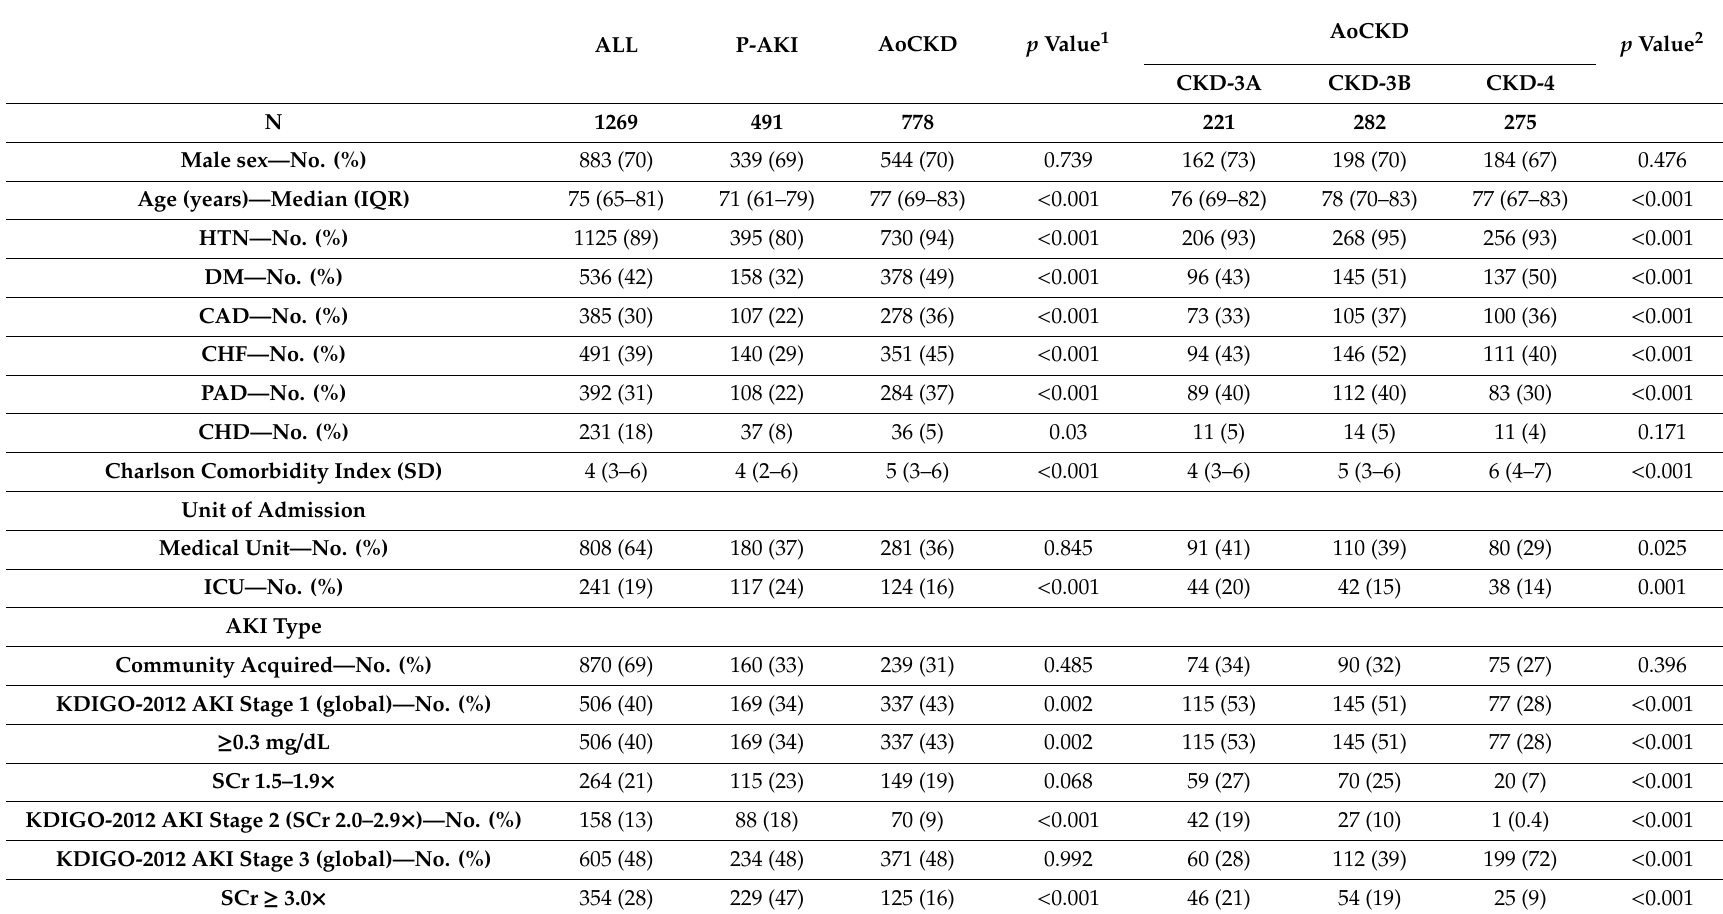
Table 2. Baseline Characteristics of AKI and AoCKD Groups and Distribution across KDIGO-2012